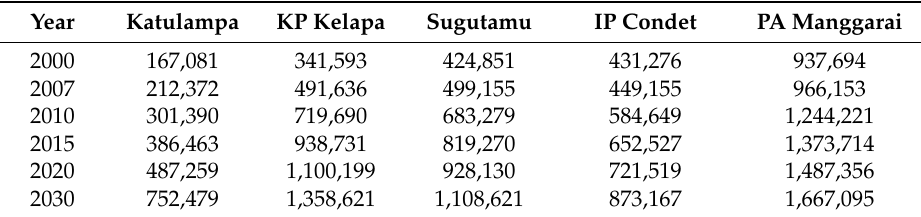
Table 1. The yearly trend for population distribution in different command areas of the study area. Year Katulampa KP Kelapa Sugutamu IP Condet PA